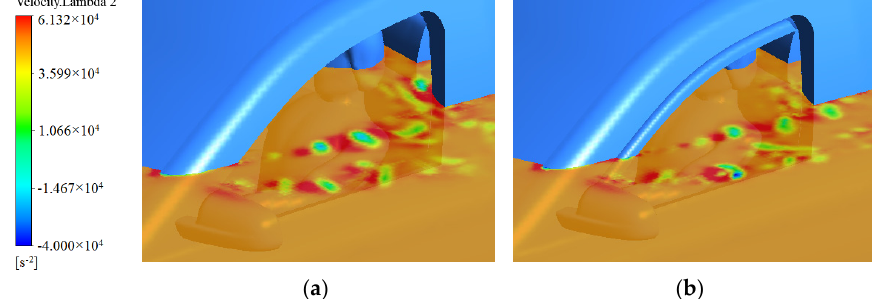
Figure 6. Vorticity on the horizontal plane through the driver’s ear. ( a ) Without the visor; ( b ) With the visor.